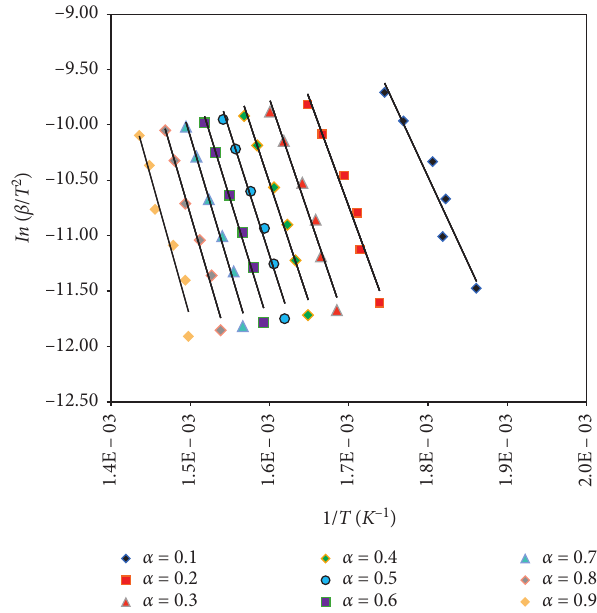
Figure 7: KAS plots ln ( β / T 2 ) versus 1/ Τ for sample PNVP- co - PSMA 50–50.